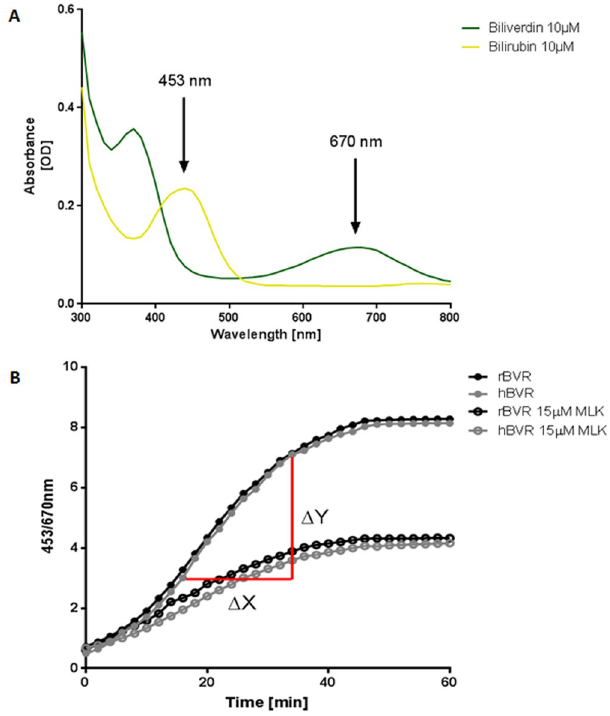
Figure 2. ( A ) The biliverdin reductase activity assay makes use of the different wavelengths at which bilirubin (453 nm) and biliverdin (670 nm) have their peak absorbance [OD]. The absorbance spectrum was measured at a concentration of 10 μ mol/L in a total volume of 200 μ L at 37 °C by a Synergy HT multi-detection reader. ( B ) Biliverdin reductase activity is derived from the speed at which biliverdin is converted to bilirubin by calculating the slope over the linear part of the enzymatic reaction. Cytosolic rat or human biliverdin reductase (rBVRA or hBVRA) was pre-incubated at 37 °C with 10 μ mol/L biliverdin, bovine serum albumin (BSA 400 μ g/ml) and 50 mM TrisHCL pH8.7. The reaction was started by adding NADPH to a final concentration of 100 μ mol/L in a total volume of 200 μ L. The conversion of biliverdin to bilirubin was determined by measuring absorbance every 2 minutes for 60 minutes and expressed as the ratio 453/670 nm. When 15 μ M Montelukast (MLK) is added to the reaction, the reduced slope ( ∆ Y/ ∆ X) indicates reduced BVRA